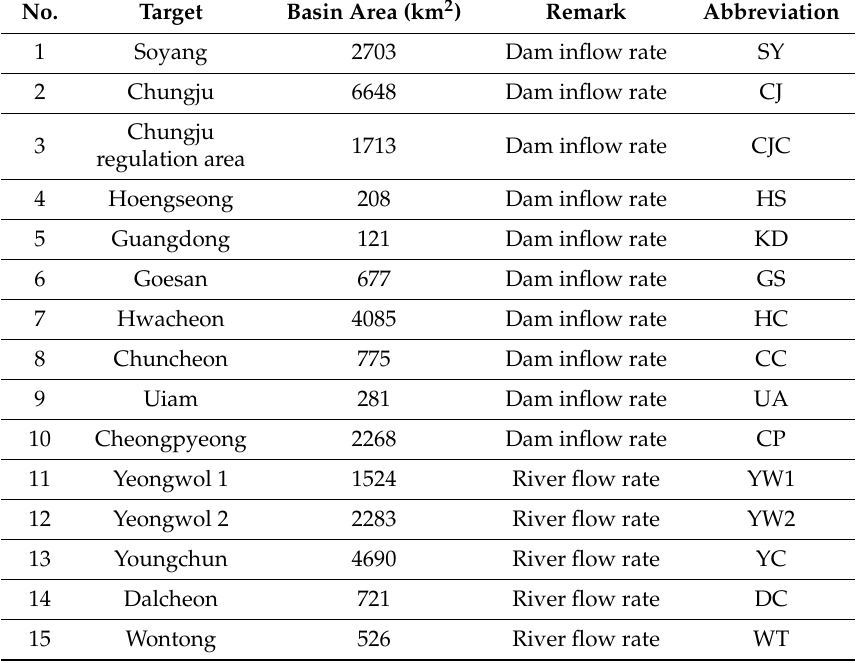
Table 6. The estimated spots’ parameters using the data on a total of 15